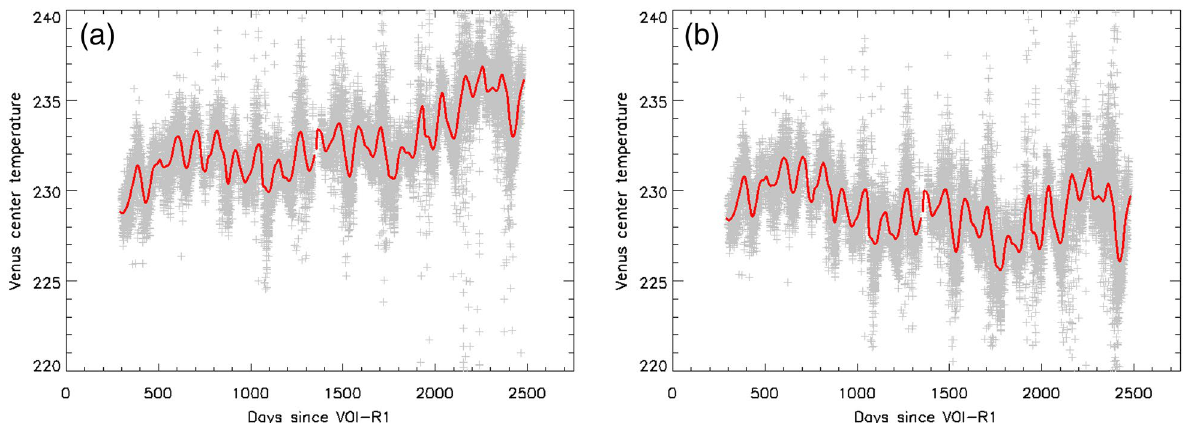
Fig. 5 Temporal variations of the temperature of Venus’ disk center a without and b with the correction. Running mean values are shown by red solid lines. The periodic variation of ~ 100 days is due to a thermal tide component following the sub‑spacecraft local time